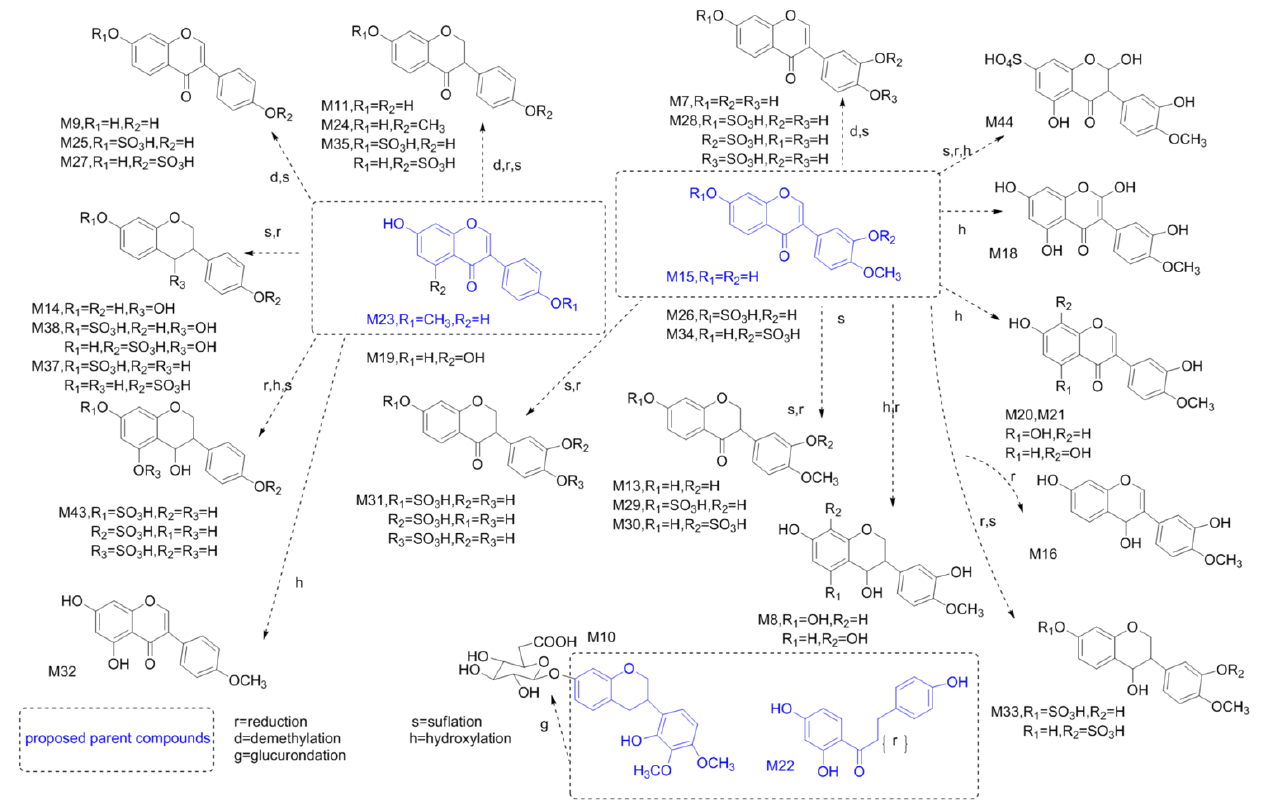
Figure 5. The main proposed metabolites identified from the urine samples of rats that had been administrated Danggui Buxue Tang